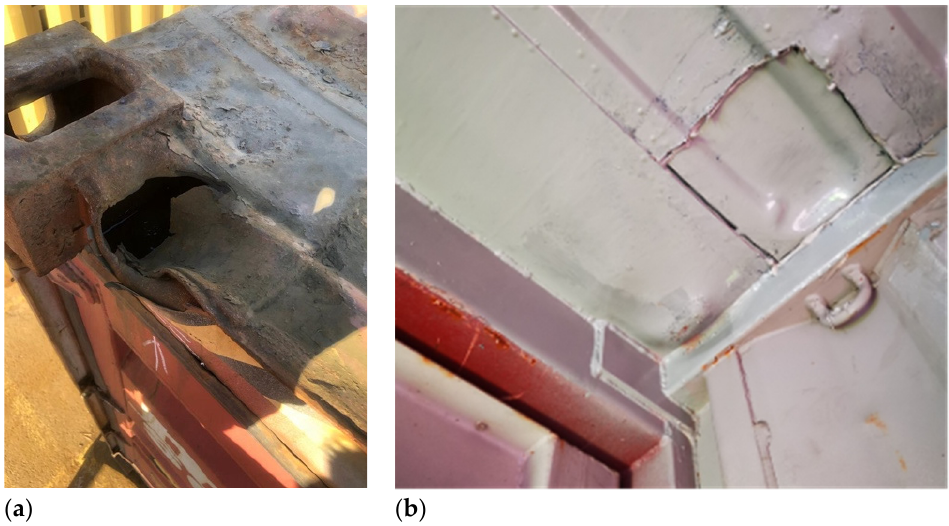
Figure 1. Results of the spreader hooking mechanism’s impact on the container’s incorrect hooking locations. Here figure ( a ) shows the result of the continuous impacts on the exterior part of the container, and ( b ) shows the result of these impacts on the interior part of the container.